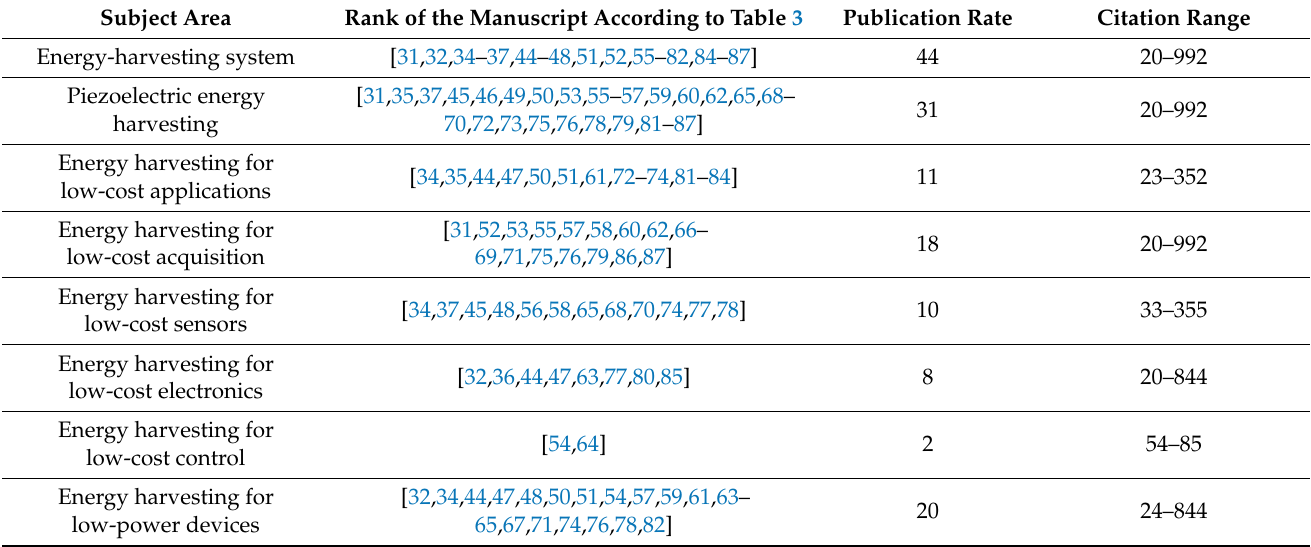
Table 8. A total of 50 manuscripts with highest citations in various fields of